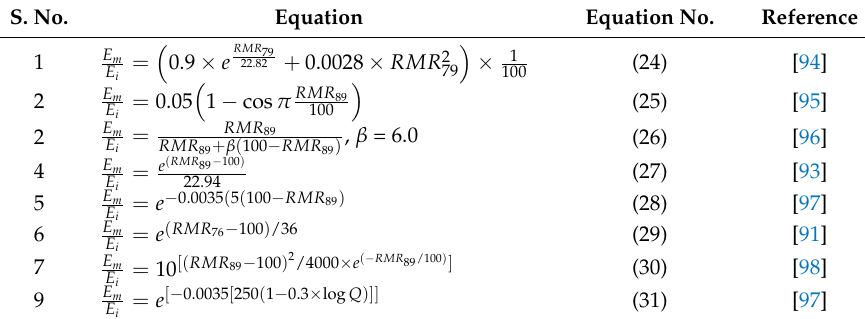
Table 5. Equations for calculation of E m with E i